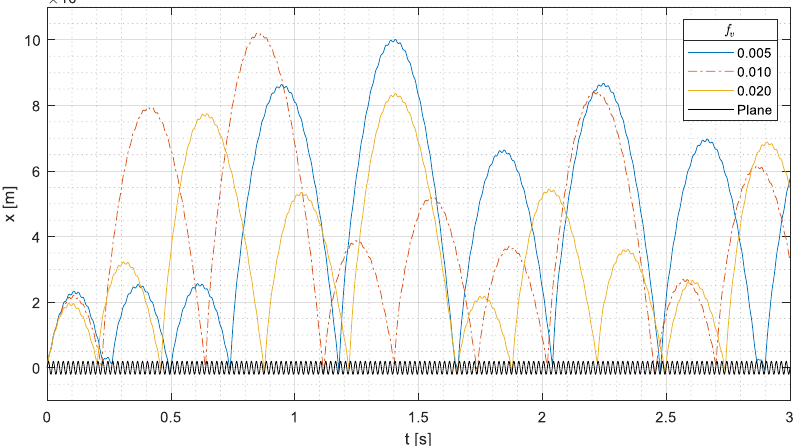
Figure 12. Numerical results, displacement of the cylindrical part along the track, 𝜃 = 3° , 𝜓 = 0 , 𝜇 𝑐 = 0.3, 𝜇 𝑠 = 0.6 , and parametric values of 𝑓 𝑣 .